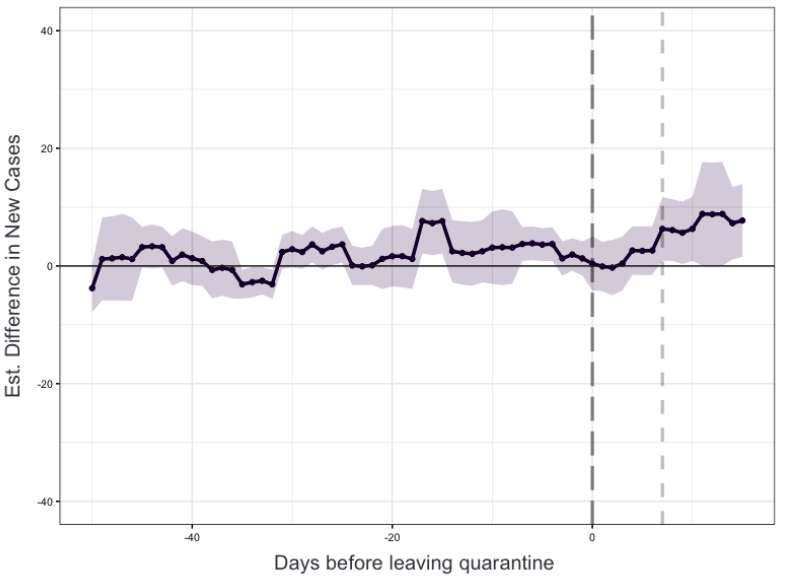
Figure 13. Estimation of the effect of lifting the quarantine on COVID-19 new cases for low-income communes in the Metropolitan